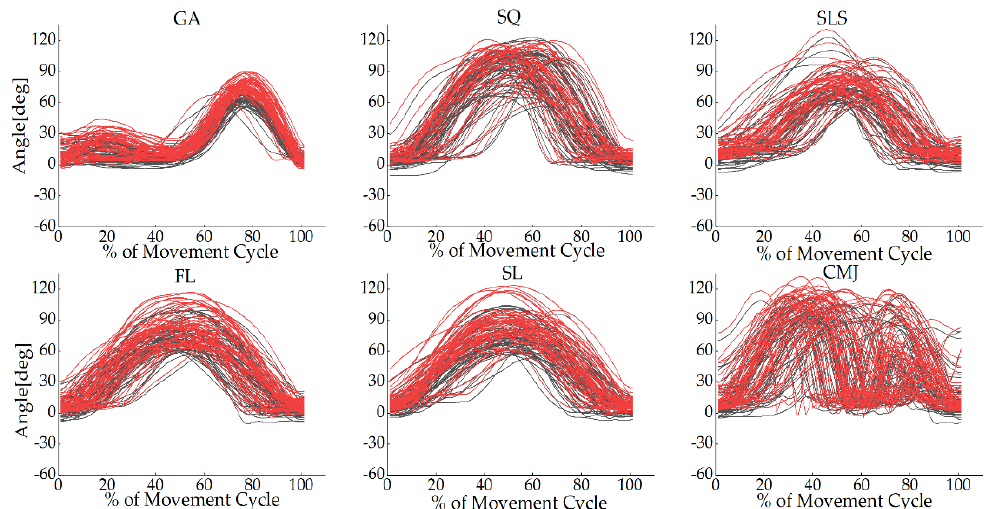
Figure 3. Knee joint angles in the sagittal plane for each participant in all tasks during the movement cycle of the gait (GA), squat (SQ), single-leg squat (SLS), side lunge (SL), forward lunge (FL), and counter-movement jump (CMJ). The black lines represent the OptiTrack system, while the red lines represent the Perception Neuron ® system. The Y -axis depicts joint angles in degrees, while the X -axis depicts the movement cycle in %.